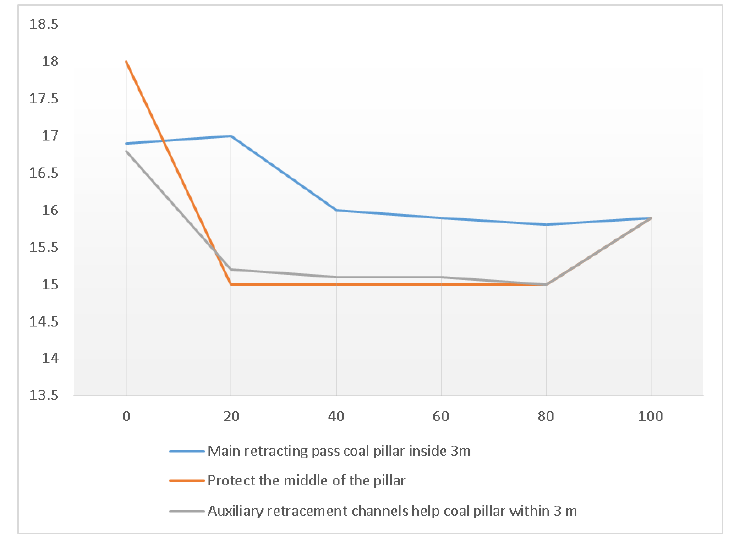
Fig. 3 Vertical stress result of main retracement